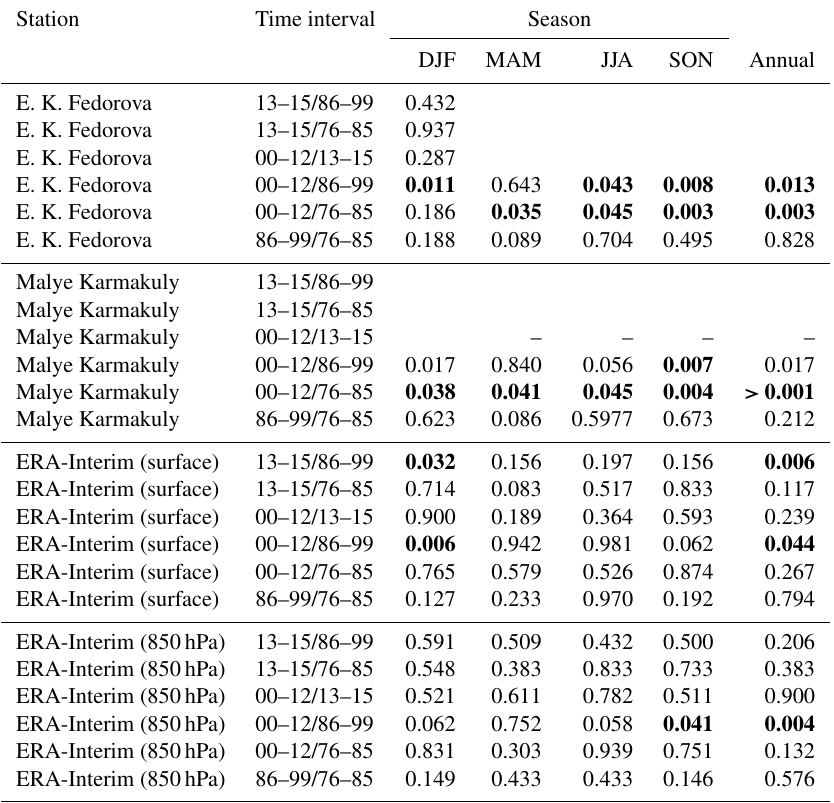
Table 3. P values for Wilcoxon tests for significant differences in mean seasonal and mean annual air temperatures, for the periods 1976– 1985, 1986–1999, 2000–2013, and 2013–2015. Following convention, p values of < 0.05 are considered significant and are highlighted in bold.